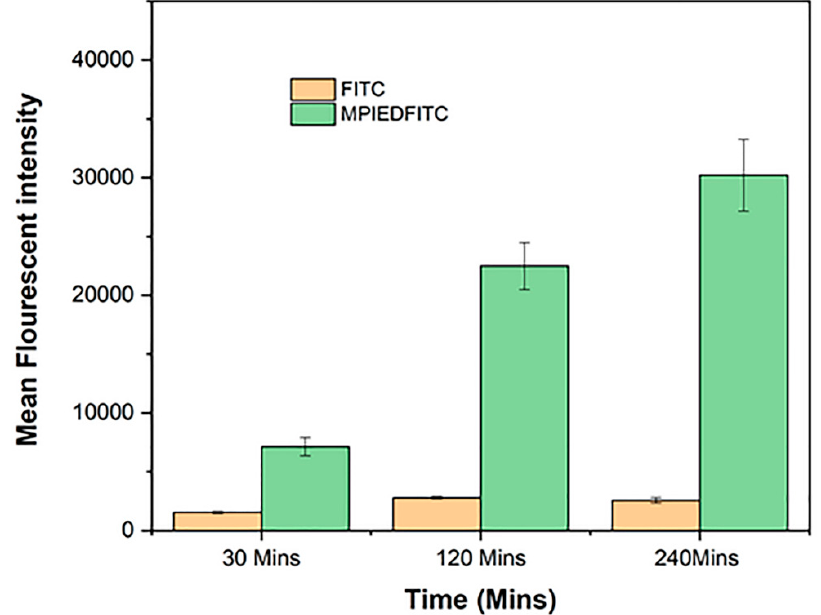
Figure 13. Flow cytometry histogram of cell count versus FITC intensity (FITC-A denotes FITC area). Data is representative of three sets of experiments.